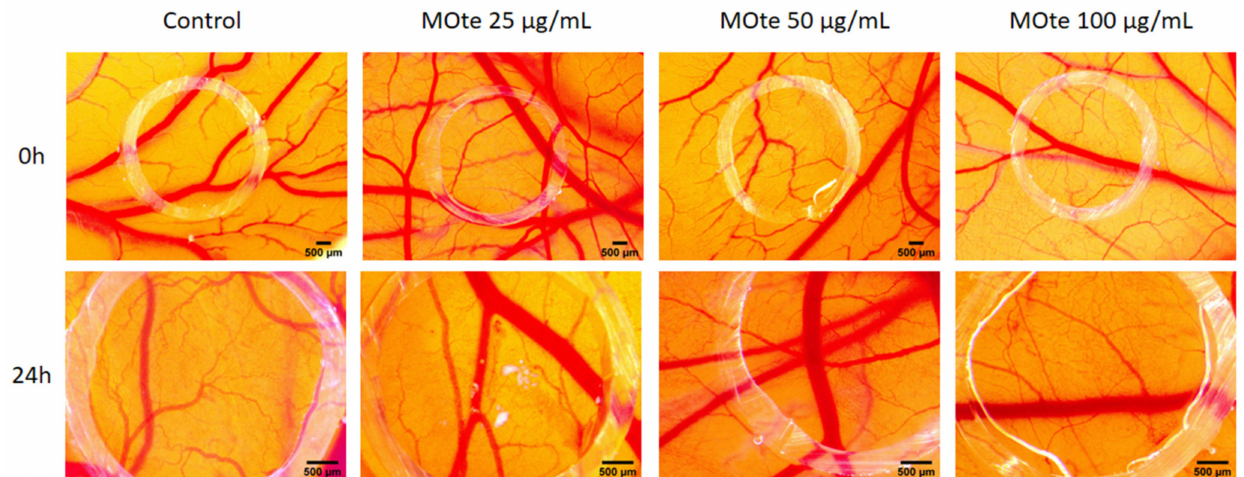
Figure 5. Stereomicroscopic images regarding the effects of Melissa officinalis total extract on the chorioallantoic mem- brane assay. Evaluation was assessed at first application contact (0 h) and after the application (24 h) of samples (three concentrations of MOte extract 25, 50, and 100 µ g/mL) and